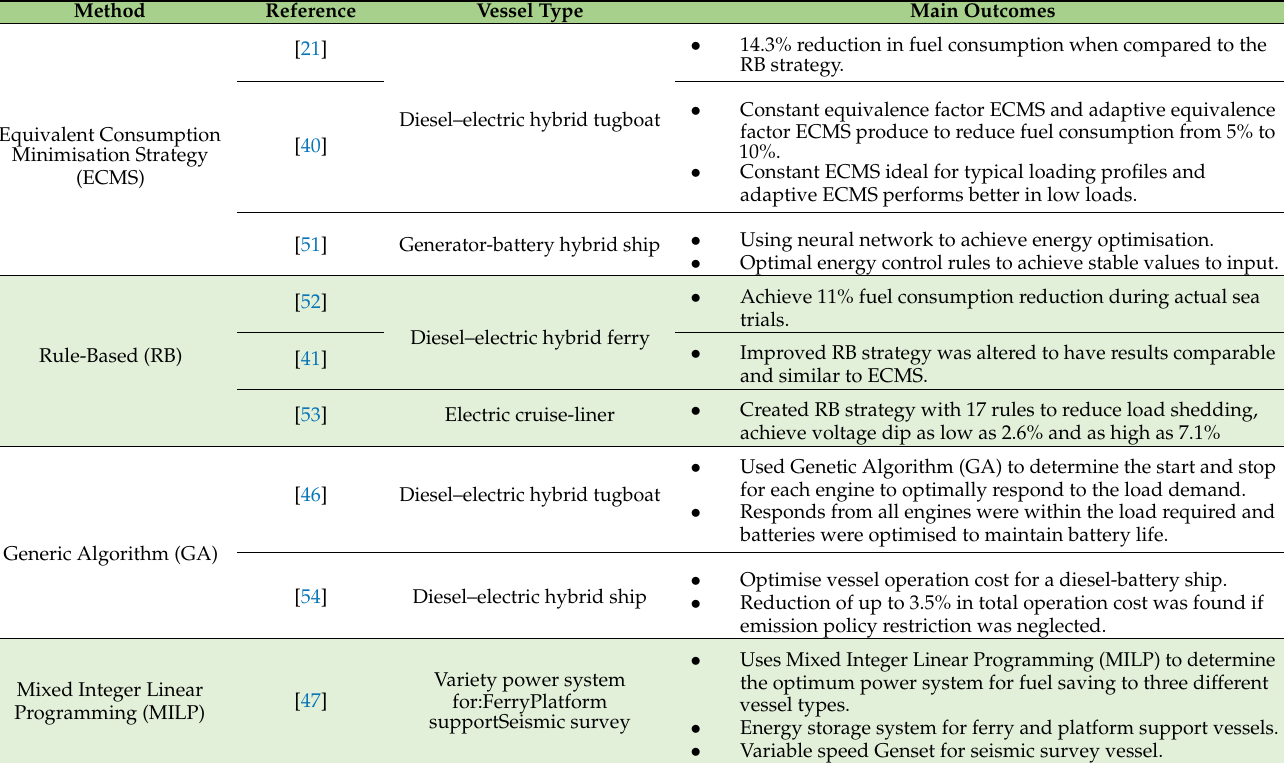
Table 3. Summary of academic studies on hybrid propulsion and control